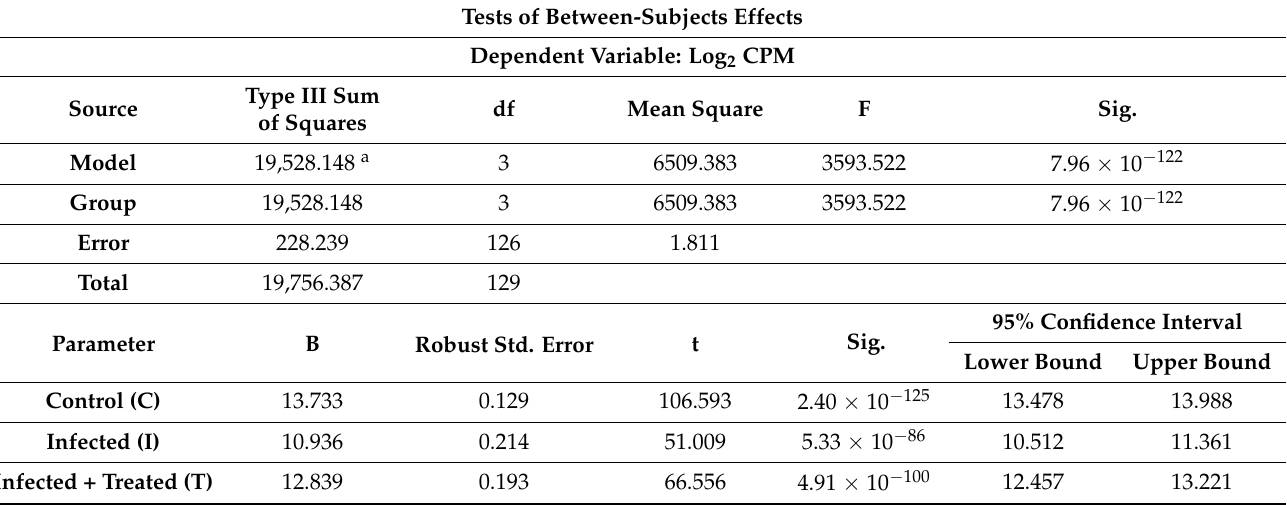
Table 3. Results of Univariate Analysis of Variance (ANOVA) among the three groups of patients and parameter estimates using robust standard errors (HC3 method). The coefficient of determination (R squared) of the model was 0.988, suggestive of good model fit with sufficient predictive power. Tests of Between-Subjects Effects